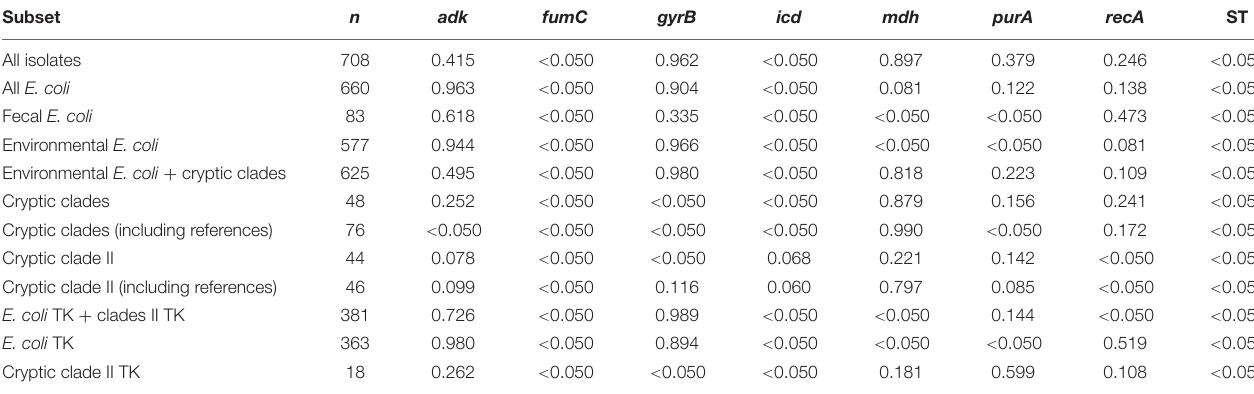
FIGURE 4 | Phylogenetic network of the 380 STs based on NeighborNet algorithm using concatenated sequence. Parallelogram denotes incompatible partition within sequence data (conflicting phylogenetic signals due to recombination or recurrent mutation). Insert is the network generated using the same dataset plus reference sequences as used in Figure 2 . References of cryptic clades I–VI, E. albertii KF1, E. fergusonii ATCC 35469, and Salmonella enterica Typhimurium LT2 were indicated. TABLE 6 | Recombination analysis by phi test (Bruen et al., 2006) with p- values